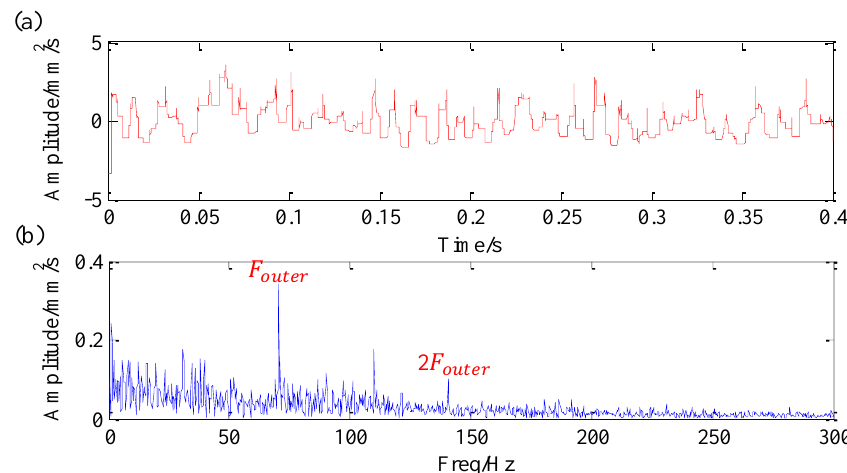
Figure 14. Filtered signal using the proposed method: ( a ) waveform and ( b ) spectrum.